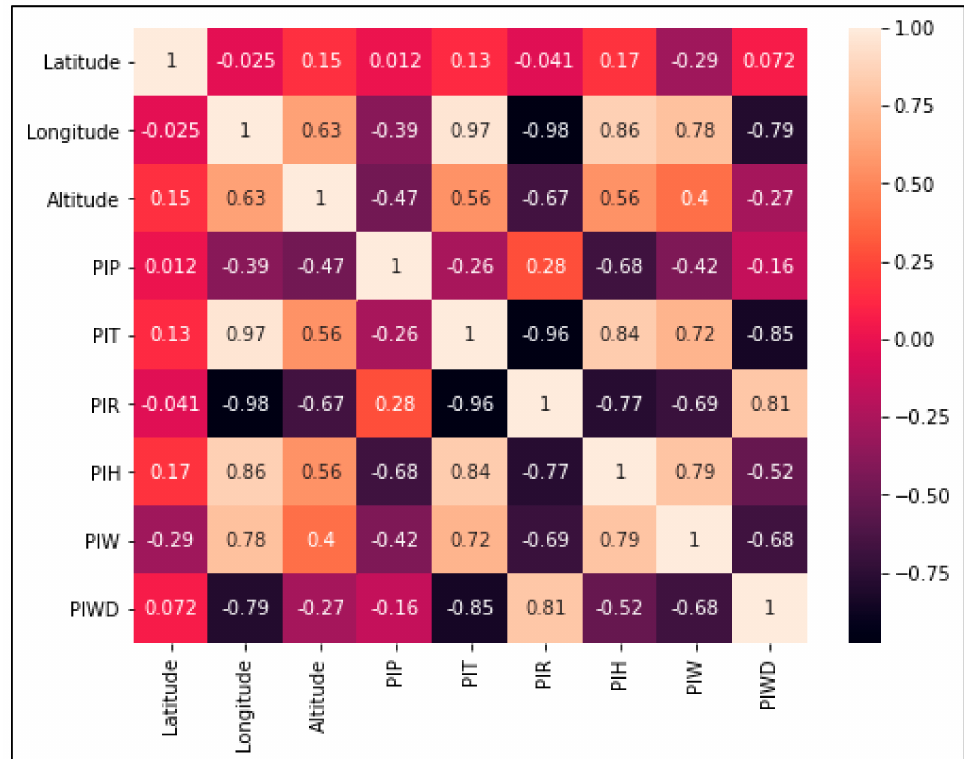
Figure 4. Correlation matrix for predictability indices for the time series made up of days without Santa Ana